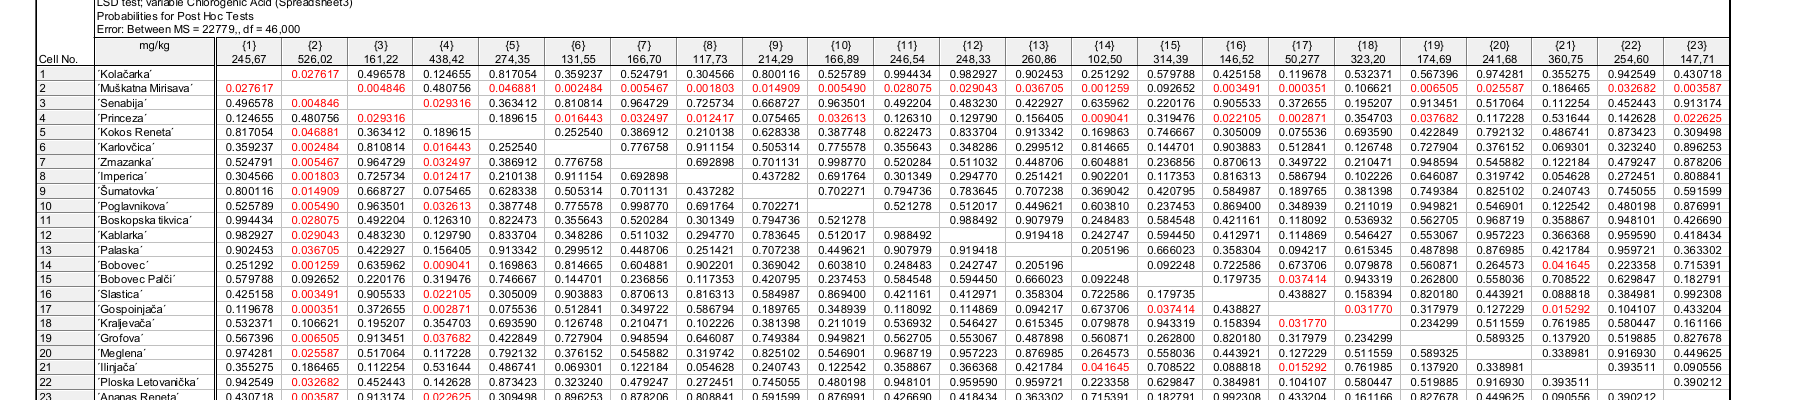
Figure A4. The statistical significance of chlorogenic acid in traditional apple varieties; the p -values of the correlations of identified polyphenols. Statistically significant p -values are marked red ( p < 0.05).